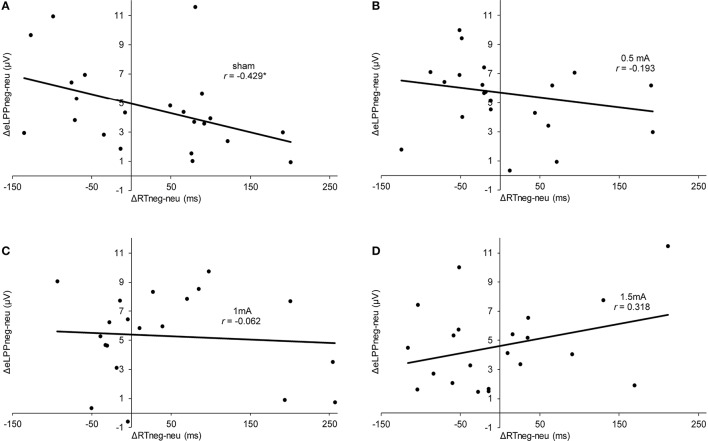
Scatter plots illustrating the correlation between ΔRTneg-neu and ΔeLPPneg-neu in the sham (A), 0.5 mA (B), 1 mA (C), and 1.5 mA (D) experimental conditions. In the sham group, the correlation was significant (*p = 0.046), while for the other experimental conditions no significant effect was found (0.5 mA:, p = 0.389;1 mA: p = 0.784; 1.5 mA: p = 0.160).